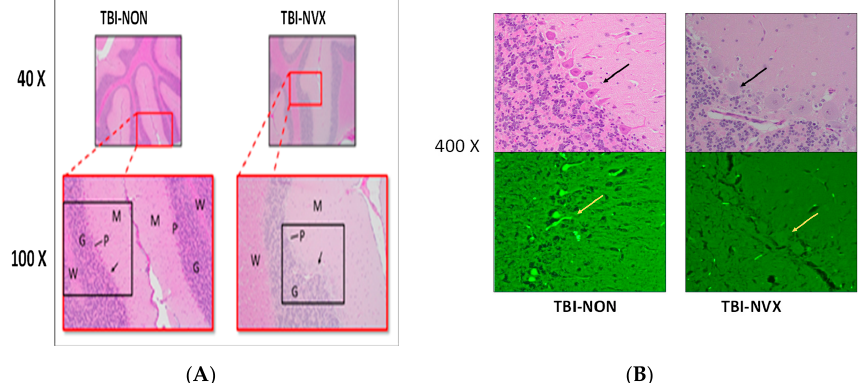
Figure 7. ( A ) Histopathology of cerebellar brain tissue. H&E stain from 40× to 400×. Red rectangles delineate the 40× areas that are further magnified by 100×. Black rectangles delineate the areas which are magnified by 200×. G = granular cell layer, M = molecular cell layer, p = Purkinje cell layer, and W = white matter; shrunken, pyknotic, and eosinophilic staining of the Purkinje cells from the TBI-NON animal. Black arrows point to the Purkinje cells further magnified at 400 × in ( B ); ( B ) High magnification (400 × ) of framed panel in ( A ); cerebellar brain tissue using H&E (top) and Fluoro-Jade B (FJB, bottom). The FJB stains at 400 × magnification are from adjacent sections to the respective H&E stains above them. Yellow arrow (FJB) points to adjacent Purkinje cells; note the fluorescent staining of the Purkinje cells in the TBI-NON animal and not in the